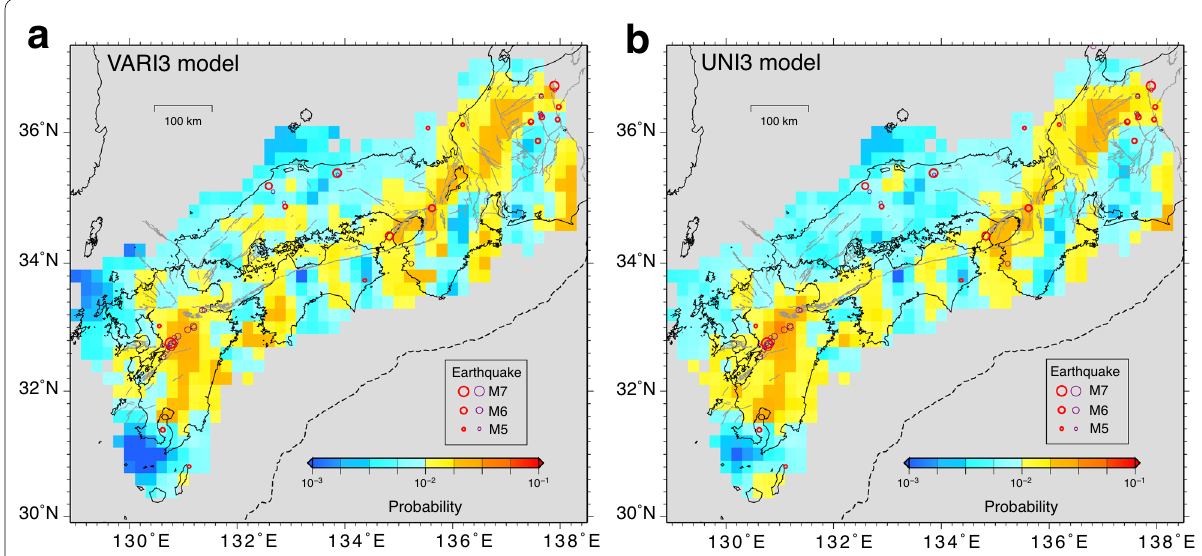
Fig. 4 Probability of M 6 crustal earthquakes over 30 years. Both red and purple circles indicate epicenters of M ≥ of 20 km for 2010–2020 and red ones indicate that of declustered earthquakes. a VARI3 model and b UNI3 model ≤